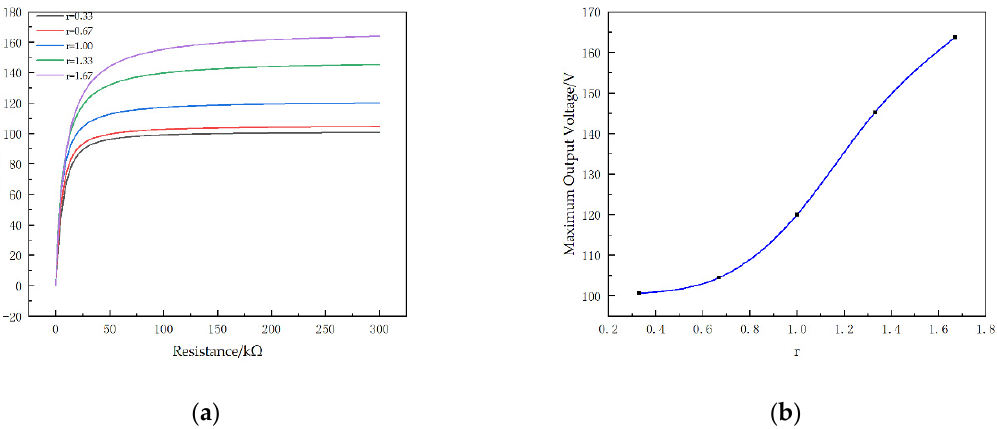
Figure 8. Output voltage of the STTM-PEH with different piezoelectric patch thicknesses. ( a ) Output voltage–resistance curves. ( b ) Maximum output voltage with different 𝑟 .